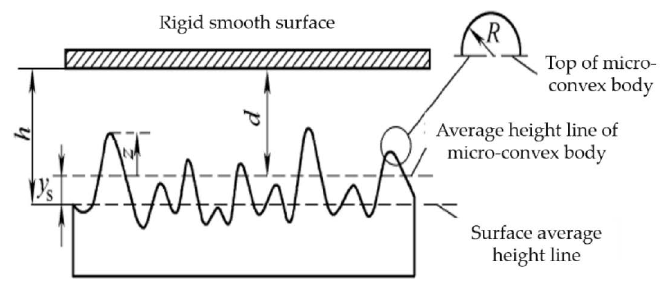
Figure 2. Rough surface and rigid smooth surface.